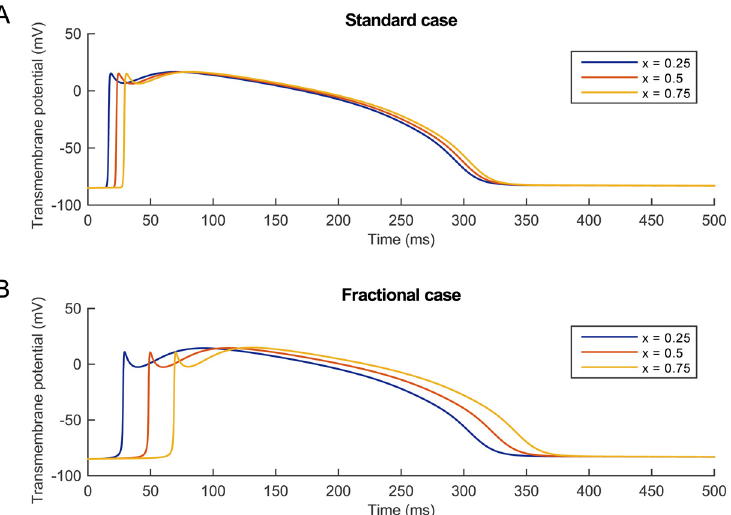
Fig 3. Temporal profile of the solution for t 2 [0,500 ms] at three equally spaced nodes P 1 ( x = 0.25), P 2 ( x = 0.5), P 3 ( x = 0.75) of the spatial domain [0, 1 cm]. (A) Solution obtained when α = 2. (B) Solution obtained when α = 1.5. In both cases the stimulus I stim = 40 μ A (cid:3) cm − 3 was applied on [0,0.05 cm] at t stim = 10 ms for two consecutive milliseconds and then removed.